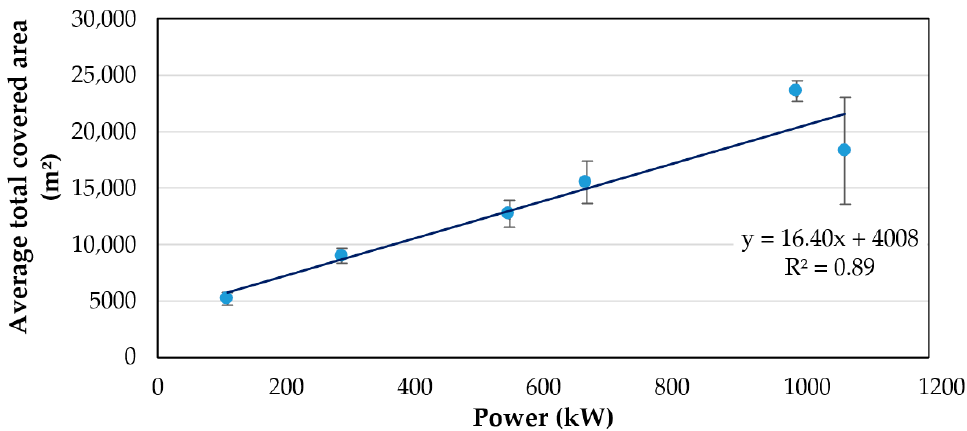
Figure 7. Relation between installed power and average total covered area (m 2 ).